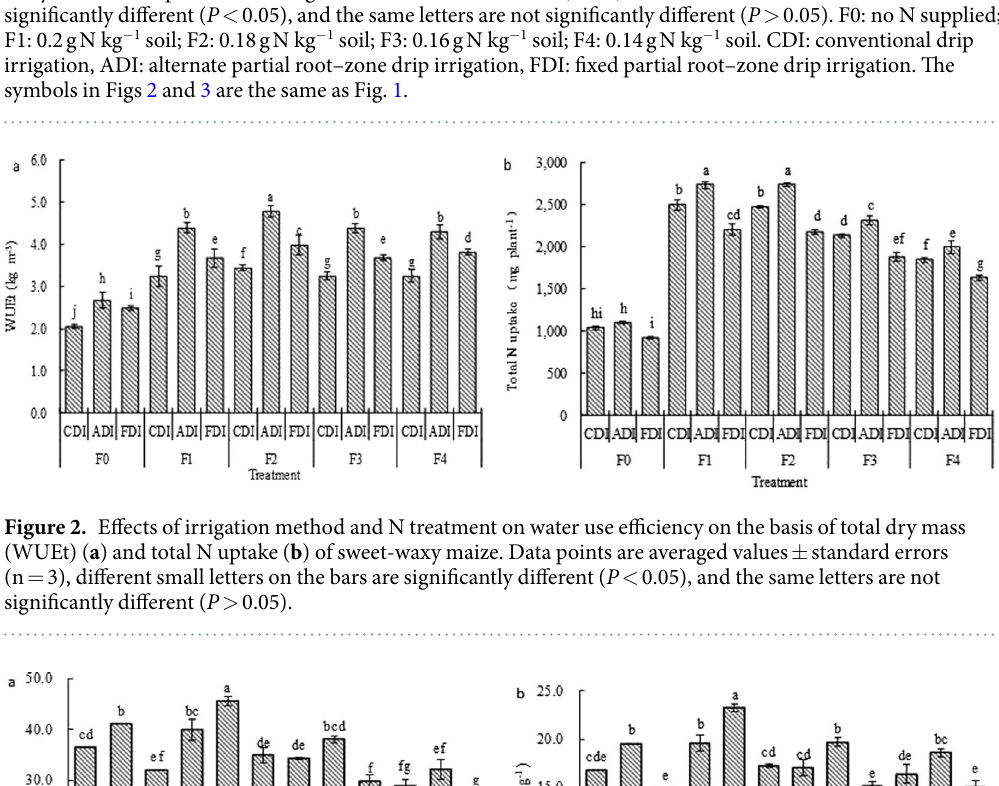
Figure 1. Effects of irrigation method and N treatment on shoot dry mass ( a ) and total dry mass ( b ) of sweet- waxy maize. Data points are averaged values ± standard errors (n = 3), different small letters on the bars are significantly different ( P < 0.05), and the same letters are not significantly different ( P > 0.05). F0: no N supplied;